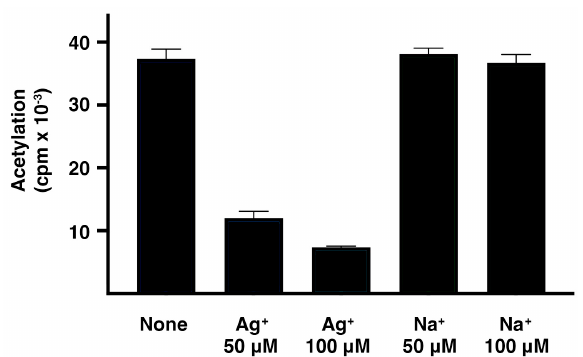
Figure 2. Effect of Ag + on AAC(2 ′ )-Ia activity. Assays were performed in triplicate by the phospho- cellulose paper binding method with soluble extracts obtained from E. coli TOP10(pUC57AAC2Ia) cells. The reaction mixture contained 200 mM Tris HCl pH 7.6 buffer, 0.25 mM MgCl 2 , 330 μ M plazomicin, the indicated concentrations of silver acetate (Ag + ) or sodium acetate (Na + ), and 0.05 μ Ci of [acetyl-1- 14 C]-acetyl-coenzyme A (specific activity 60 μ Ci/ μ mol) in a final volume of 30 μ L. The enzymatic reactions were allowed to proceed at 37 °C. After 30 min incubation, 20 μ L were spotted on phosphocellulose paper strips, which were immersed in water at 80 °C. Following this, the paper strips were washed twice by immersion in room temperature water. Finally, the phosphocellulose paper strips were left to dry and counted to determine the bound radioactivity, which corresponds to acetylated plazomicin.